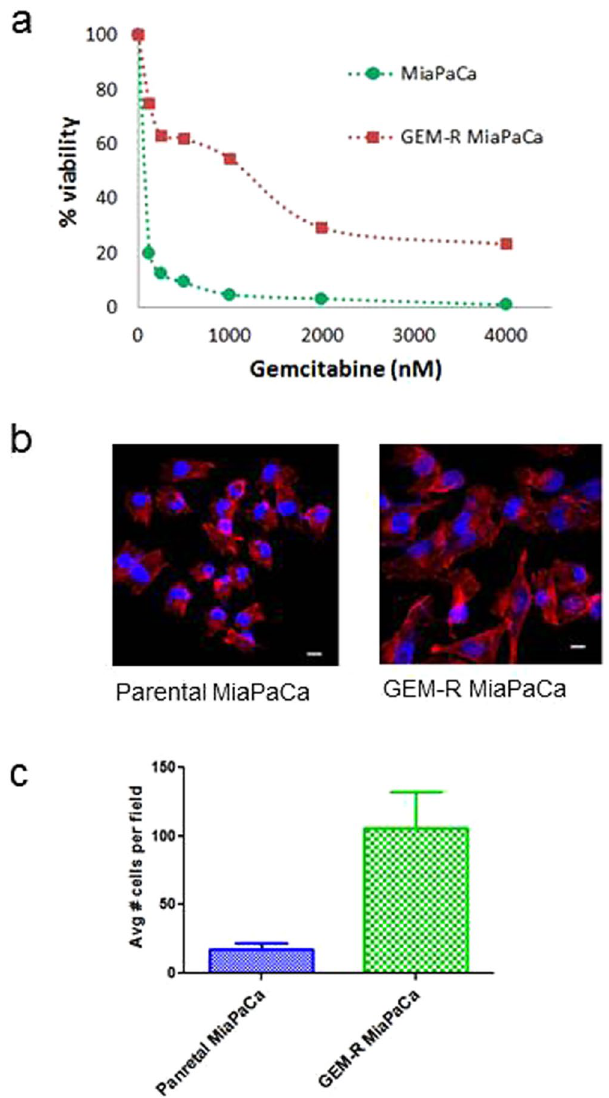
Figure 1. Development of GEM-R MiaPaCa PDAC cells. ( a ) Comparison of GEM-R MiaPaCa cells with the parental MiaPaCa in dose response to GEM treatment. ( b ) Cell morphological images of GEM-R MiaPaCa cells (right) and the parental MiaPaCa cells (left). ( c ) Cell migration assay - the number of cells migrating through the transwell was 4x higher in GEM-R MiaPaCa compared to the parental cells. The error bars represent